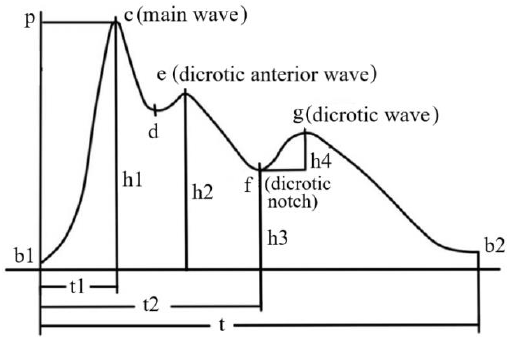
Figure 11. Key feature points of pulse wave.